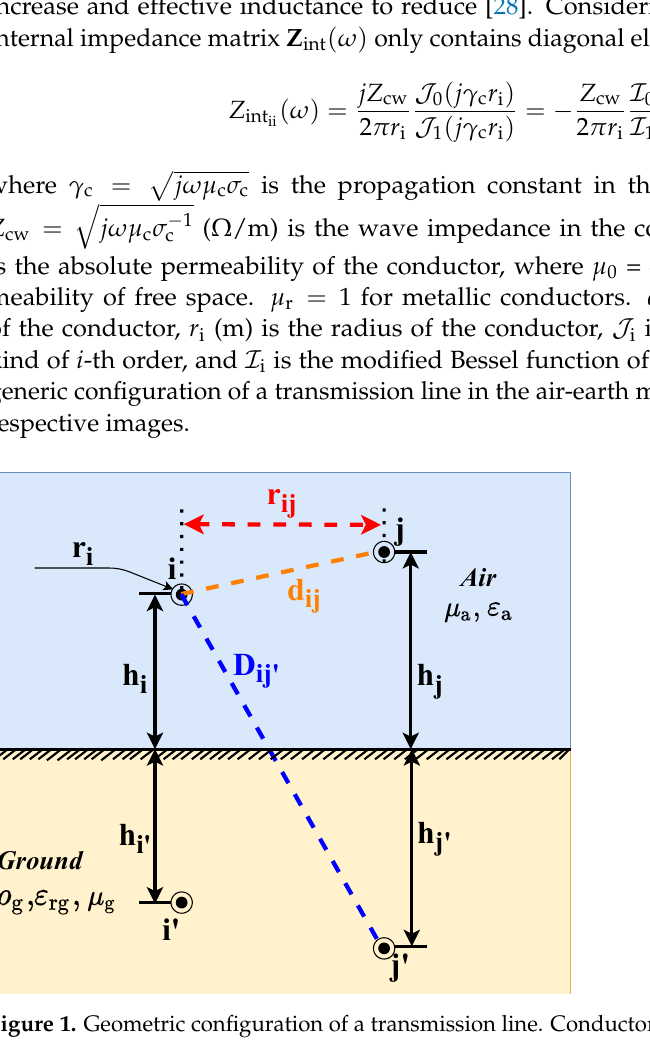
Figure 1. Geometric configuration of a transmission line. Conductors i and j and its images i (cid:48) and j (cid:48)